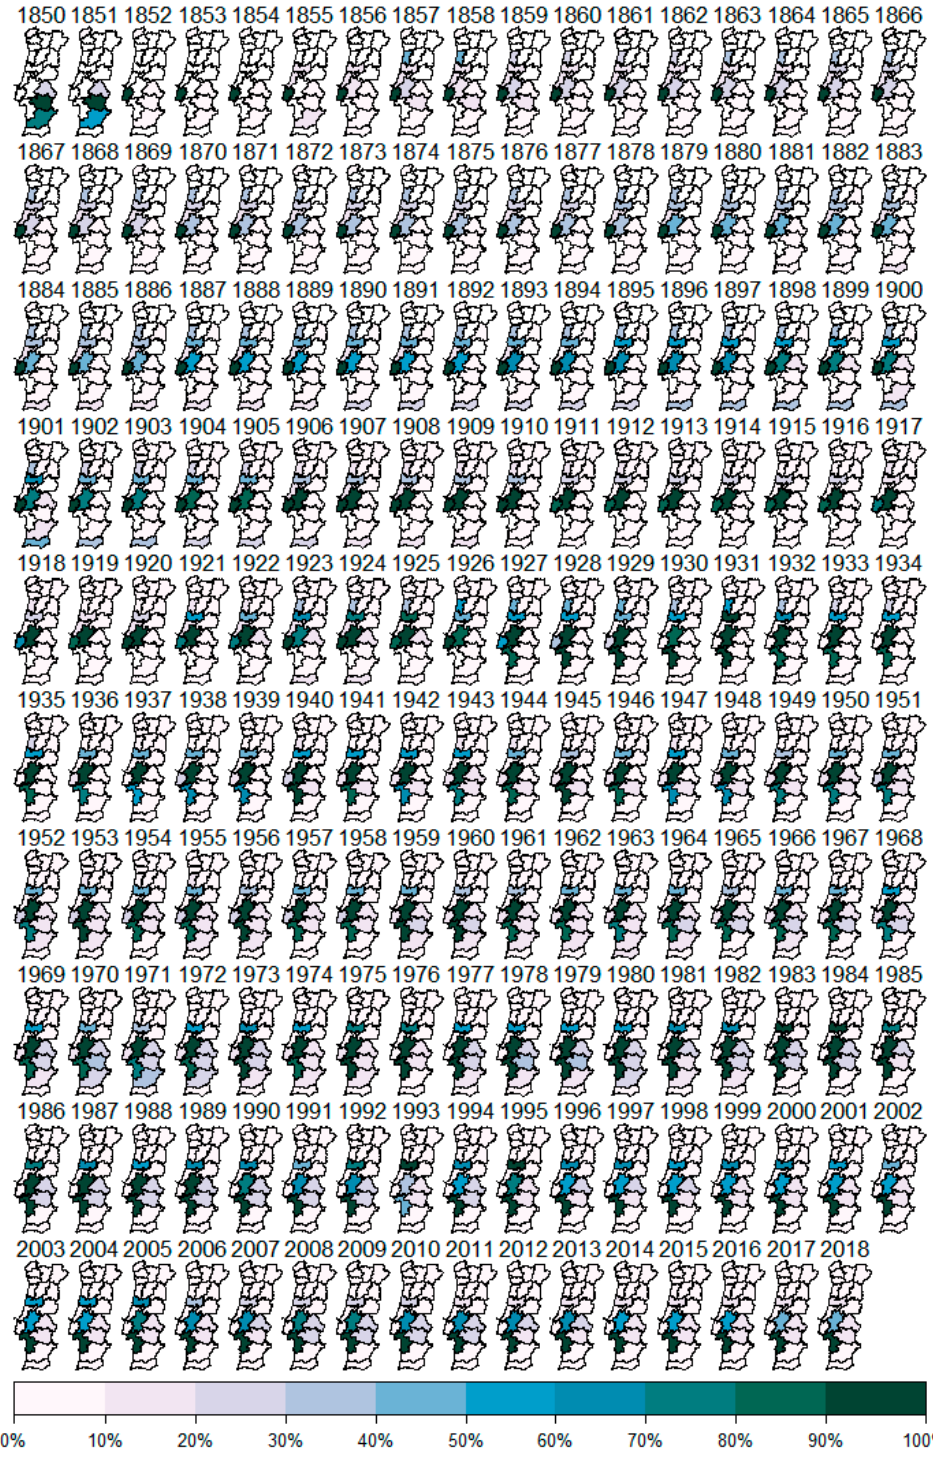
Figure 9. Spatiotemporal pattern of rice production (1850–2018).